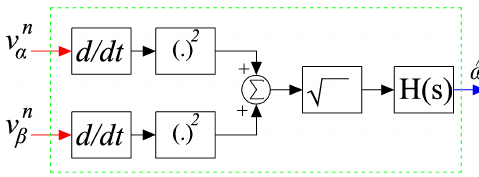
Figure 3. Block diagram of the considered frequency estimation